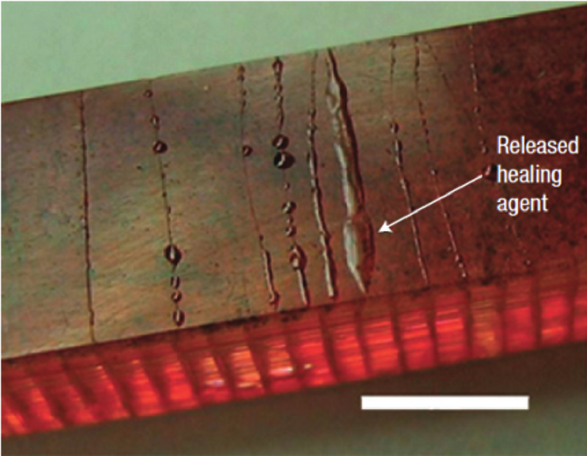
Figure 7 Optical image of a self-healing system with a microvascu- lar network after damage (scale bar, 5 mm). Reprinted with permis- sion from [38]. Copyright 2007, Macmillan Publisher Ltd: Nature Materials.